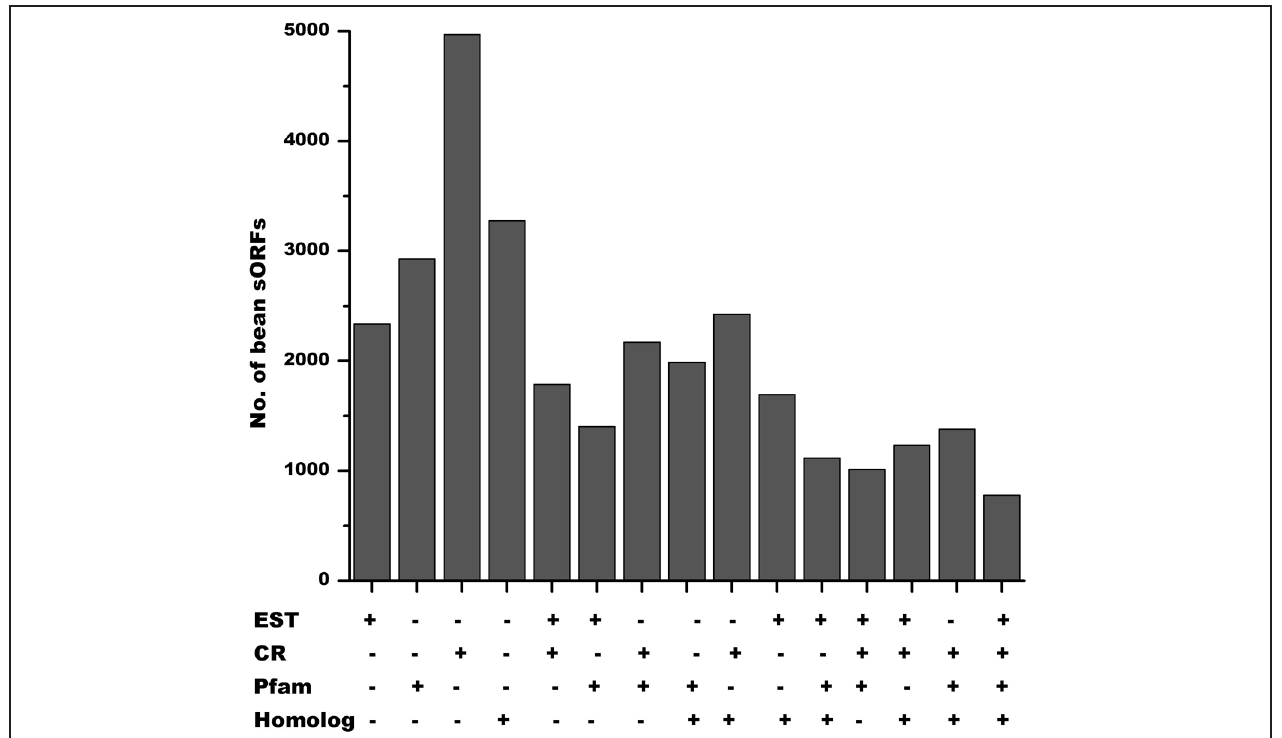
to SPs found in different plant species. According to the Phytozome annotation, 4970 belong to one or more protein families. 2553 sORFs in P. vulgaris have at least one of these types of evidence of functionality, whereas 2321 have two of them and a total of 776 sORFs have all of